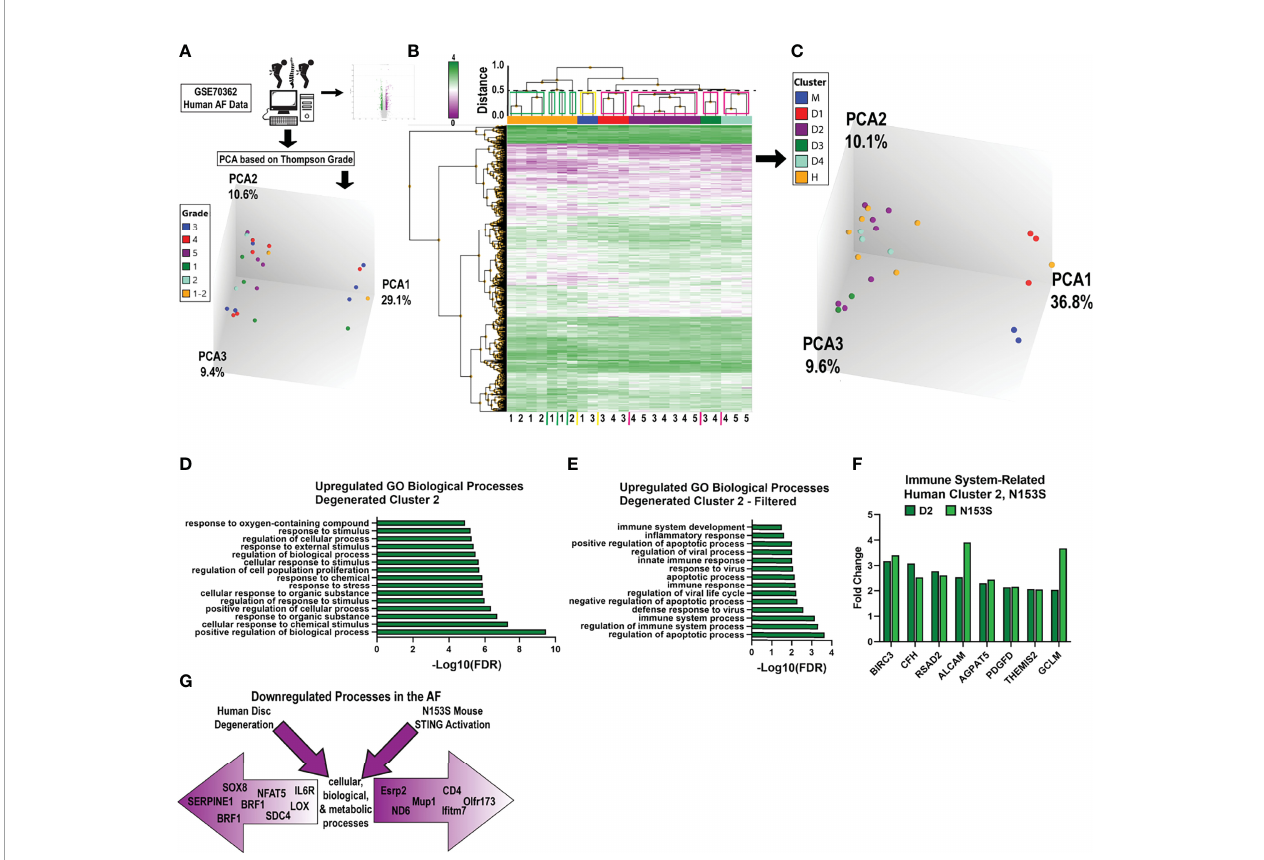
FIGURE 7 | Transcriptomic changes in the AF of N153S mice do not recapitulate signatures of human degeneration. (A) Schematic showing PCA clustering based on Thompson Grades of human AF microarray samples (n = 24) deposited in GSE70362. (B) Hierarchical clustering of DEGs, p < 0.05 showed four healthy clusters (green boxes), one ambiguous cluster (yellow box), and four degenerated clusters (pink boxes), with a Euclidean distance cutoff of 0.5. (C) PCA of clusters obtained in B, where all healthy clusters were grouped into a single cluster, H. (D) Representative GO biological processes of upregulated genes between cluster D2 (degenerated) and cluster H (healthy). (E) GO biological processes of upregulated genes between D2 and H that overlap with N153S GO terms related to immune and in fl ammatory responses. (F) Fold change of upregulated DEGs related to an immune response that are common to D2 (dark green) and N153S (light green) transcriptomic pro fi les. (G) Schematic showing that downregulated genes in the AF of degenerated human AF tissues and N153S AF tissues broadly correlate to cellular, biological, and metabolic processes but diverge in terms of genes contributing to these broad categories of